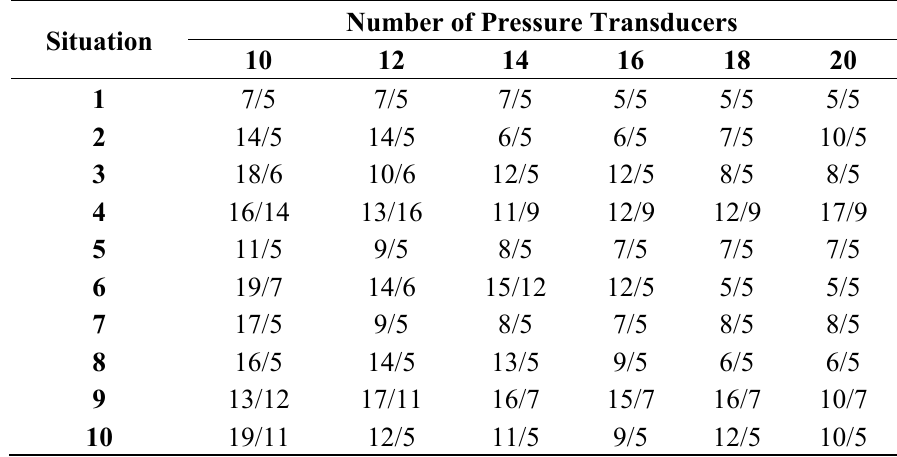
Table 4. Number of reliable leaky pipes in the first WDN (scenario 1/scenario 2).